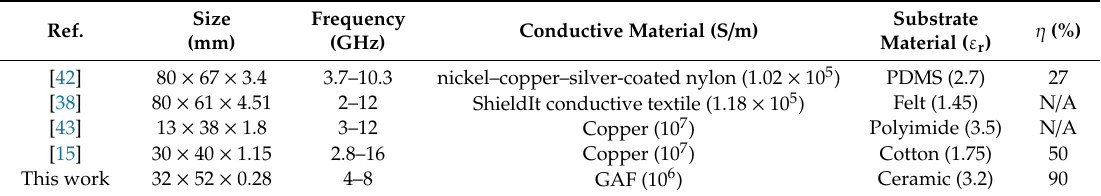
Table 1. Comparison of the proposed antenna with some